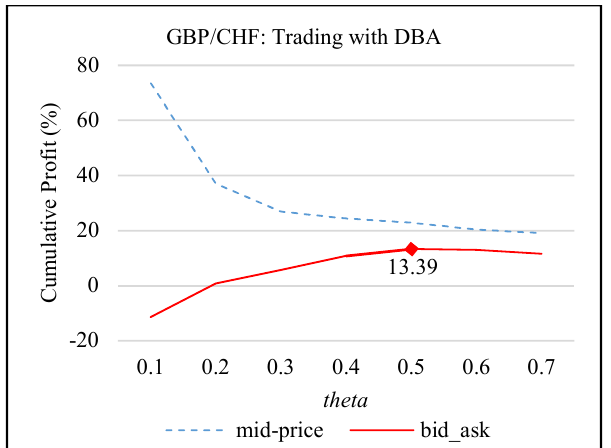
Figure 5. Variation of cumulative profits generated by DBA using mid-prices (dashed blue line) and using bid/ask price (solid red line). Source: Bakhach et al. [14].